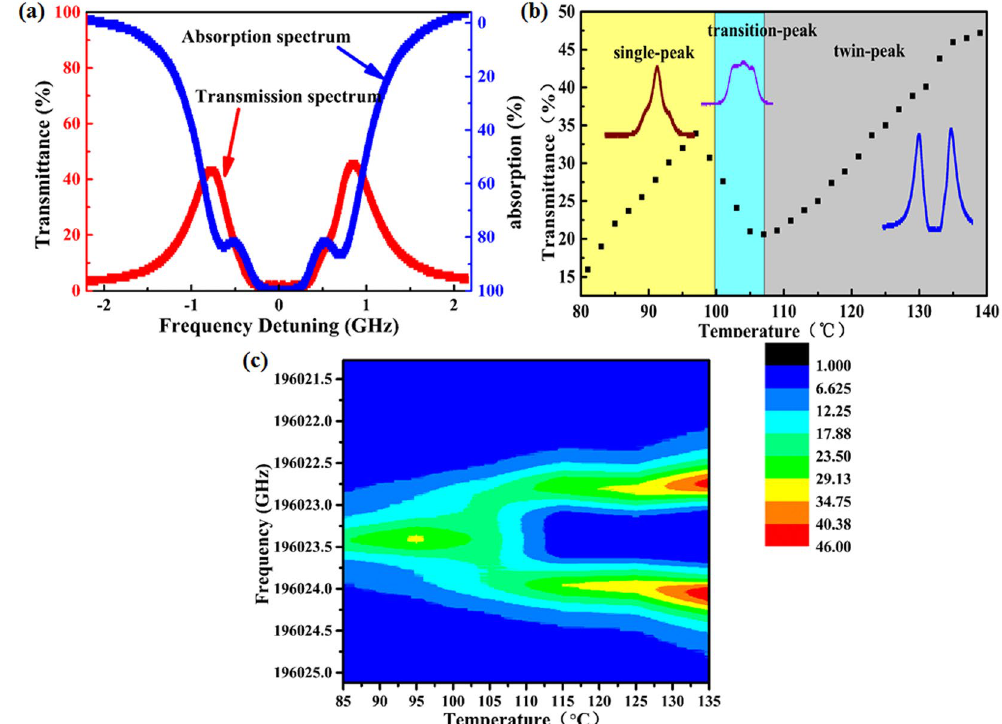
Figure 2. (a ) The measured absorption spectrum (red curve) and measured transmission spectrum (blue curve) of the improved LESFADOF. The measured absorption spectrum refers to the absorption of the Rb vapor cell, the transmission spectrum refers to the transmission of the entire LESFADOF. (b) The peak transmittance of the LESFADOF at Rb 1529 nm transition as a function of the cell temperature with a static axial magnetic field of 500 G across the Rb vapour cell. The distributing region with different color shows the different transmission spectrum line-shape. (c) The transmittance of the whole LESFADOF as a function of the Rb cell temperature from 85 °C to 135 °C with a static axial magnetic field of 500 G across the Rb vapour